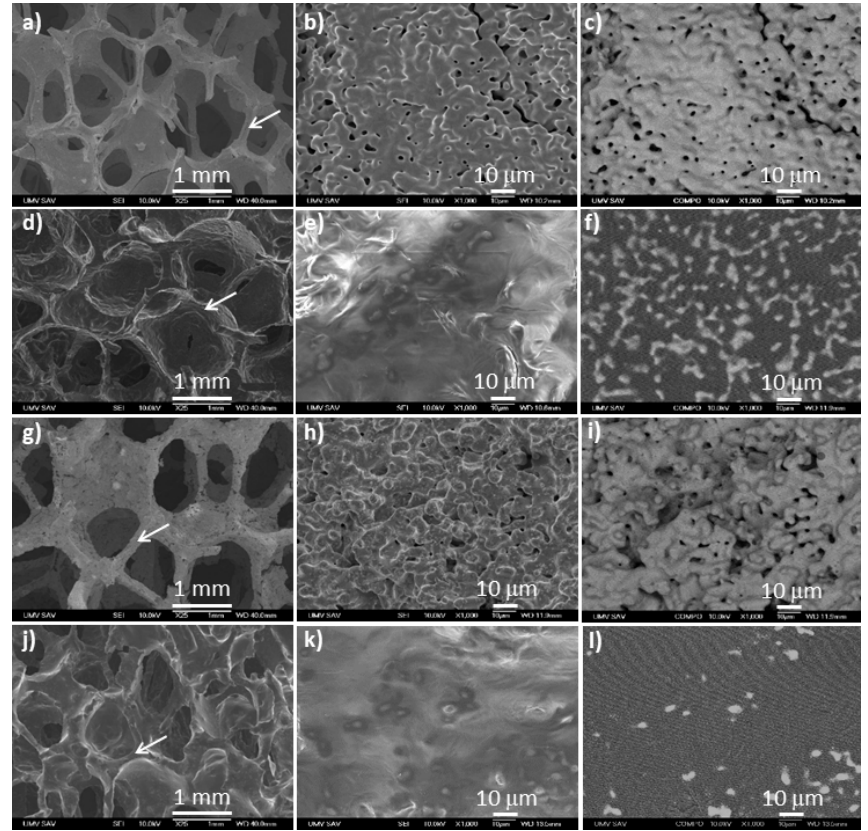
Figure 1. Scanning electron microscope (SEM) micrographs of the surface of iron-based foams: Fe sample ( a , b , c ), Fe-PEG ( d , e , f ), Fe/P ( g , h , i ), and Fe/P-PEG ( j , k , l ). Magnification: 25× ( a , d , g , j ), 1000× ( b , e , h , k ), and 1000× COMPO mode ( c , f , i , l